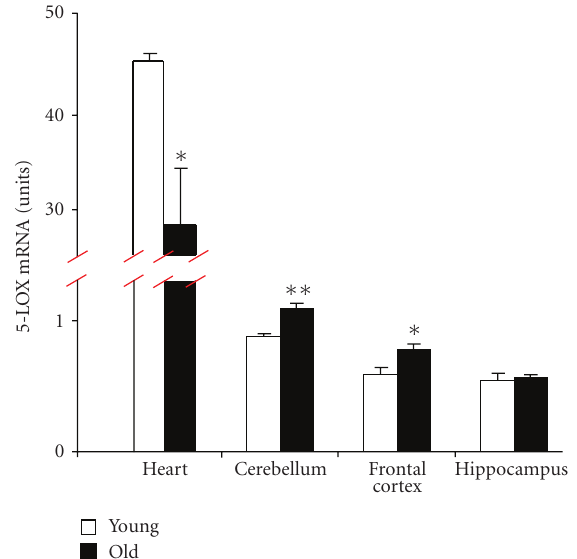
Figure 3: 5-LOX mRNA levels in heart and brain tissues of young and old mice. The content of 5-LOX mRNA in the tissues of young (2-month-old, open bars) and old (22-month-old, closed bars) mice was measured by real-time PCR. The results were normalized against the corresponding cyclophilin mRNA contents and are presented as units (the coe ffi cient of variation values amplified by a factor of 1000, see text for details). Data are expressed as mean ± S.E.M ( n = 5 − 10); ∗ P < . 05 and ∗∗ P < . 01 versus the corresponding values in young ( t